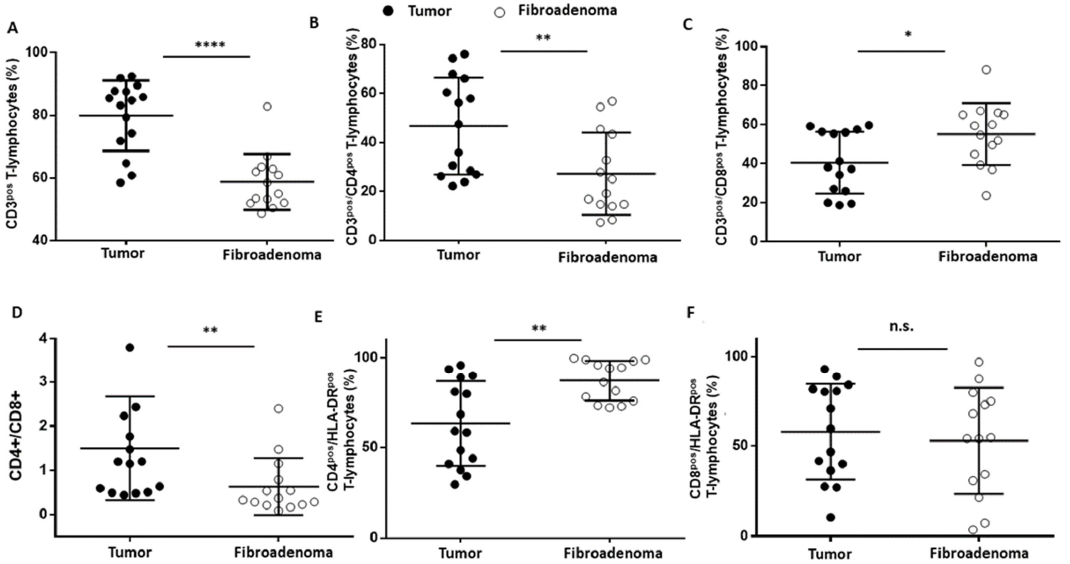
Figure 4. T-lymphocyte subset percentages were plotted, according to specific membrane receptor, in tumor (black dots) and fibroadenoma (white dots) tissue patients. ( A ) CD3 pos T-lymphocytes. ( B ) CD3 pos /CD4 pos T-lymphocytes. ( C ) CD3 pos /CD8 pos T-lymphocytes. ( D ) CD4 pos -CD8 pos ratio. ( E ) CD4 pos /HLA-DR pos T-lymphocytes. ( F ) CD8 pos /HLA-DR pos T-lymphocytes. The median and standard deviation are reported. * = p -value < 0.05, ** = p -value < 0.01, and **** = p -value < 0.0001; unpaired t- tests. n.s. = not significant. Table 2. Statistical values of the T-lymphocytes subsets. Values are reported as the median percent- age of gated cells .